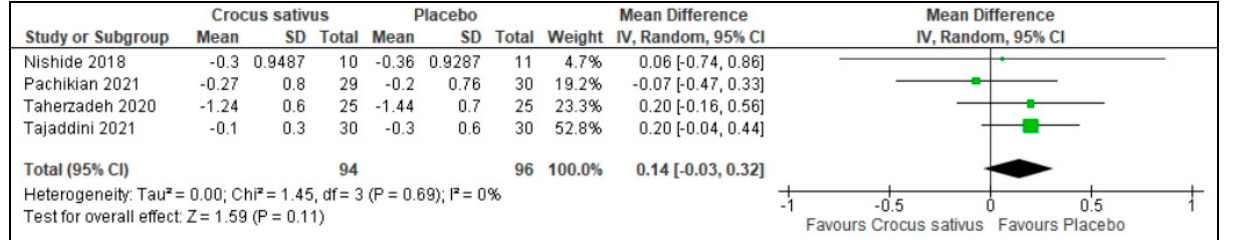
Figure 10. Forest plot for the outcome use of sleep medications [26,27,29,30]. Note: Line indicates confidence interval and the green square indicates effect estimate. Black diamond indicates cumulative effect estimate and its confidence interval.